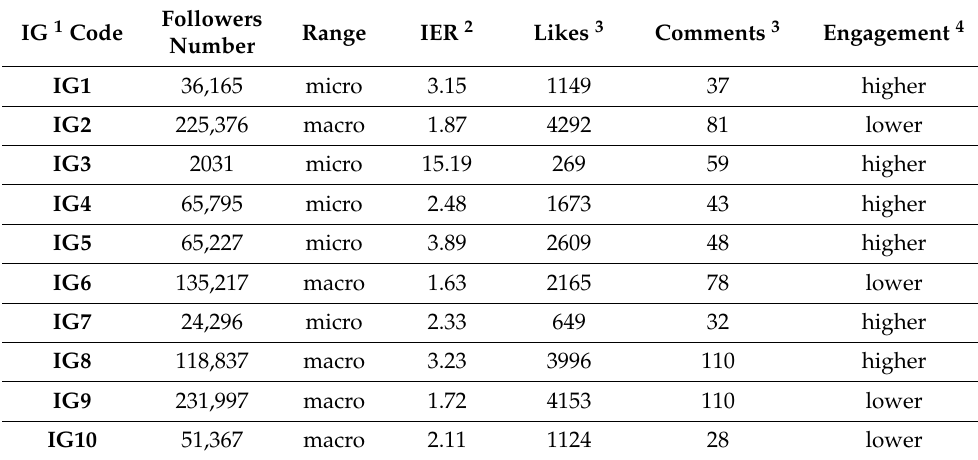
Table 2. Characteristic of Instagramers’